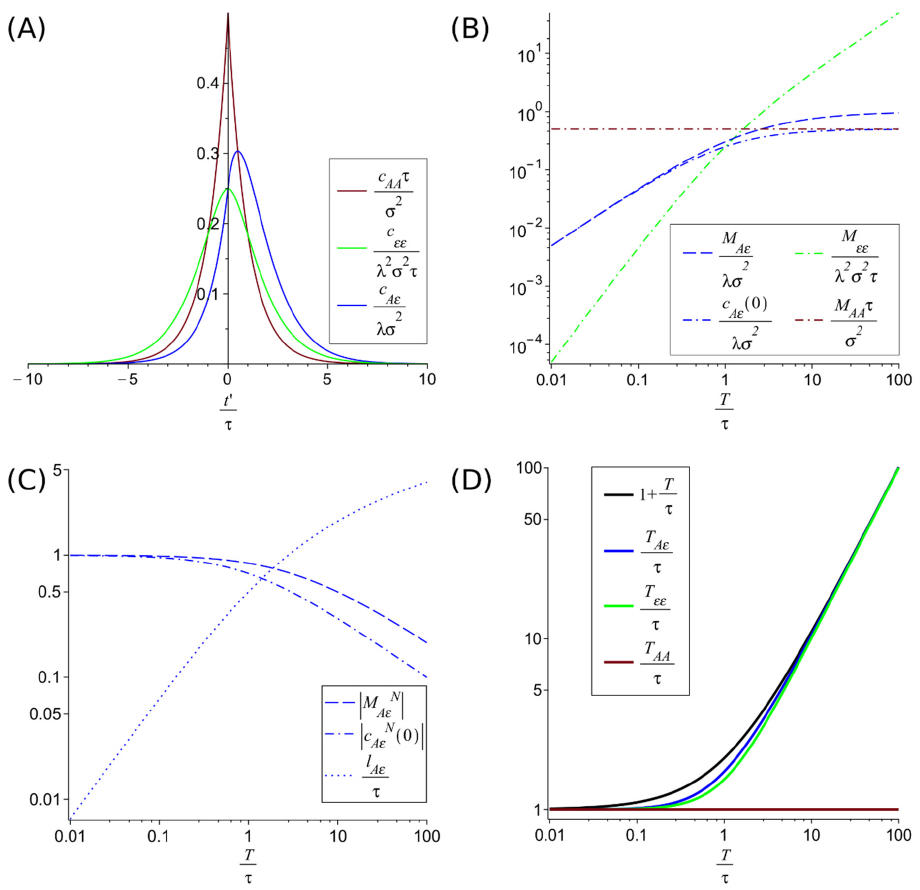
Figure 2. Correlation functions with their maximums and their values at t ′ = 0 and correlation times. ( A ) represents the adimensionalized correlation functions 𝑐 (cid:3084)(cid:3084) (𝑡’) (green), 𝑐 (cid:3002)(cid:3002) (𝑡’) (red) and 𝑐 (cid:3002)(cid:3084) (𝑡’) (blue) adimensionalized for the case 𝛼 = 𝑇/𝜏 = 1 . ( B ) compares the adimensionalized maxima of the autocorrelations function 𝑀 (cid:3002)(cid:3002) and 𝑀 (cid:3084)(cid:3084) (which coincide with the value at 𝑡 (cid:4593) = 0 of the respec- tive autocorrelation) with the maxima of the adimensionalized crosscorrelation function 𝑀 (cid:3002)(cid:3084) and its value at zero delay 𝑐 (cid:3002)(cid:3106) (0) . Their normalized values, 𝑀 (cid:3002)(cid:3084)(cid:3015) = 𝑀 (cid:3002)(cid:3084) /(cid:3493)𝑐 (cid:3002)(cid:3002) (0)𝑐 (cid:3084)(cid:3084) (0) and 𝑐 (cid:3002)(cid:3084)(cid:3015) (0) = 𝑐 (cid:3002)(cid:3084) (0)/(cid:3493)𝑐 (cid:3002)(cid:3002) (0)𝑐 (cid:3084)(cid:3084) (0) are shown in ( C ), with the delay of the cross-correlation maximum 𝑙 (cid:3002)(cid:3084) . ( D ) compares the correlations times 𝑇 (cid:3002)(cid:3106) , 𝑇 (cid:3084)(cid:3084) and 𝑇 (cid:3002)(cid:3002) . These plots illustrate the hierarchies for temporal correlations and for the maxima of the correlations discussed in the main text. In particular, it shows that for low damping (large 𝛼 = 𝑇/𝜏 ) the crosscorrelation time 𝑇 (cid:3002)(cid:3084) increases, allowing longer-term predictions, despite the decrease in accuracy that can be seen from the decay of the normalized maximum of the crosscorrelation 𝑀 (cid:3002)(cid:3084)(cid:3015) . 3.1. Maxima of the Correlation Functions The autocorrelation function of the environmental fluctuations 𝑐 (cid:3002)(cid:3002) (𝑡 (cid:4593) ) and the au- tocorrelation function of the species 𝑐 (cid:3084)(cid:3084) (𝑡 (cid:4593) ) , which are symmetric, have their maximum at the origin, 𝑡 (cid:4593) = 0 ,